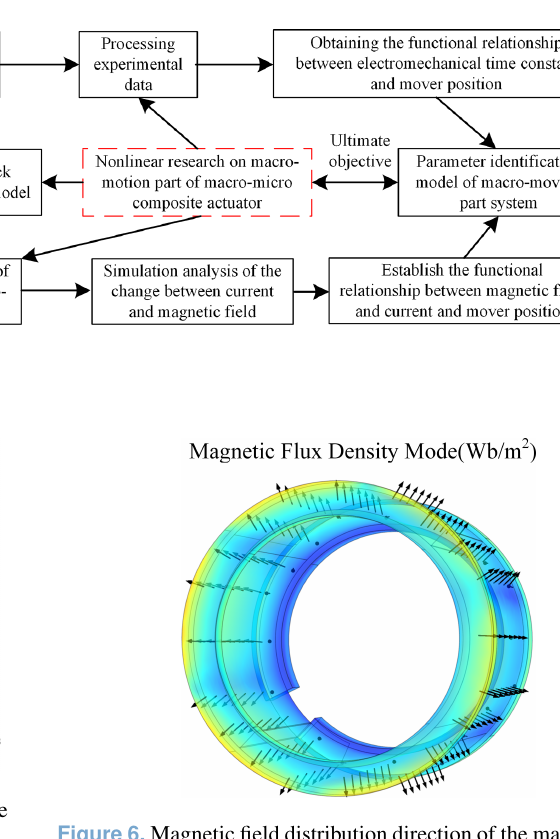
Figure 6. Magnetic field distribution direction of the macro-motion coil.